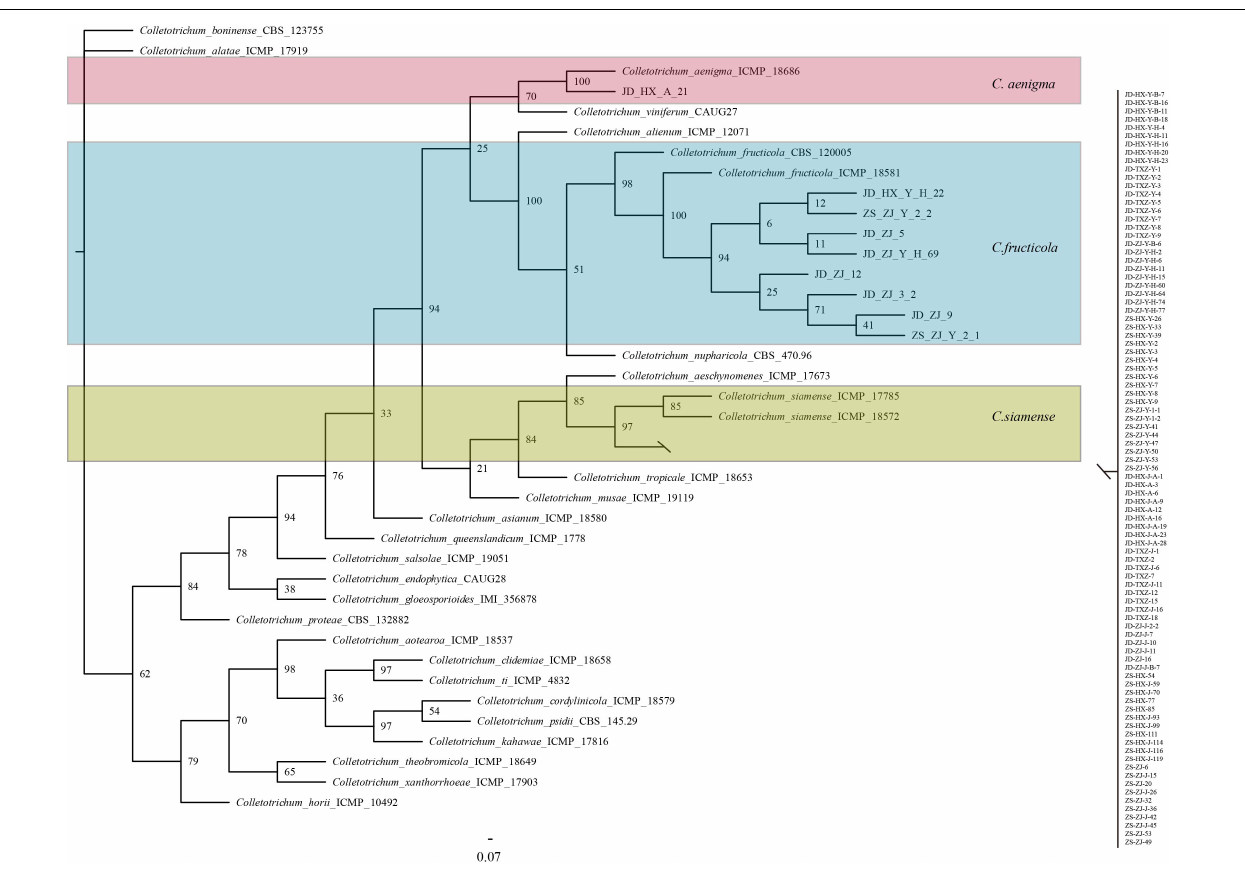
FIGURE 2 | Bayesian inference phylogenetic tree of the Colletotrichum spp. isolated from strawberry belonging to Colletotrichum gloeosporioides species complex. The tree was constructed based on ACT, CAL, CHS, GAPDH, and ITS. C. boninense was used as an outgroup. The scale bar shows 0.07 expected changes per